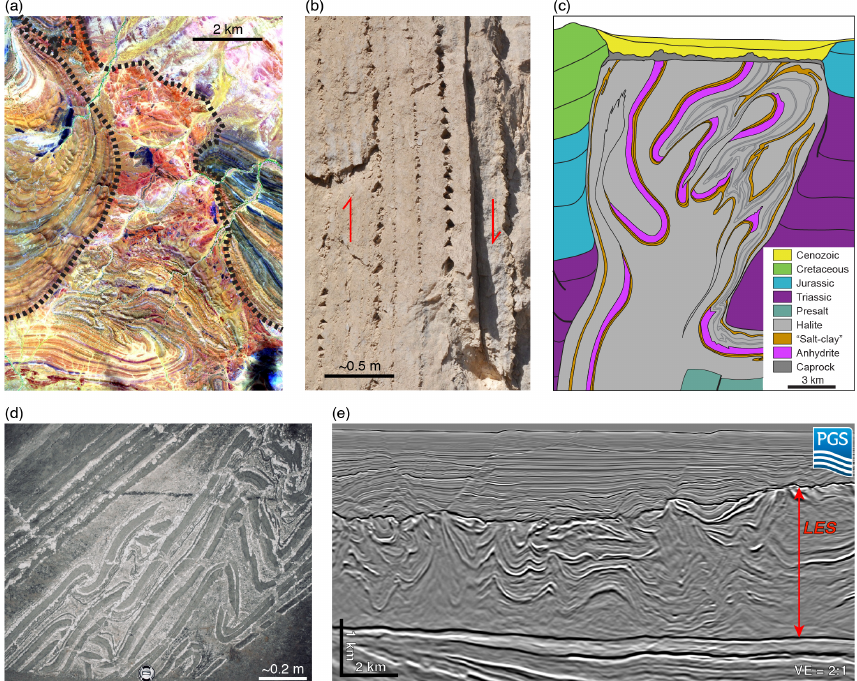
Figure 2. Examples of intrasalt deformation. (a) HyMap image with oblique cross-sectional view of exposed Witchelina diapir in the Willouran Ranges, South Australia; black dotted line marks the edge of the diapir, which has randomly oriented stringers of carbonates, siliciclastics, and volcanics in its upper half and a large stringer with recumbent isoclinal folds in the lower half (adapted from Hearon et al., 2015). (b) Photo of exposed Mt. Sedom diapir in Israel showing vertical beds of halite with bedding-parallel trains of boudins of eroded-out marls showing clockwise rotation and the indicated sense of shear (see Alsop et al., 2015). (c) Cross section of a diapir in northern Germany constrained by subsurface mine data, showing boudins of anhydrite (purple) entrained in complexly folded halite (adapted from Jackson and Hudec, 2017, itself after Hofrichter, 1980). (d) Photograph of tunnel wall in the Wieliczka salt mine, southern Poland, showing anhydrite- mudstone boudins (medium grey) thrusted and folded within halite matrix (see Krzywiec et al., 2018). (e) 3-D depth-migrated seismic profile (vertical exaggeration 2 : 1) from the Santos Basin, Brazil, with complex internal deformation shown by layered halite, anhydrite, and bittern salts (data courtesy of PGS Investigação Petrolifera